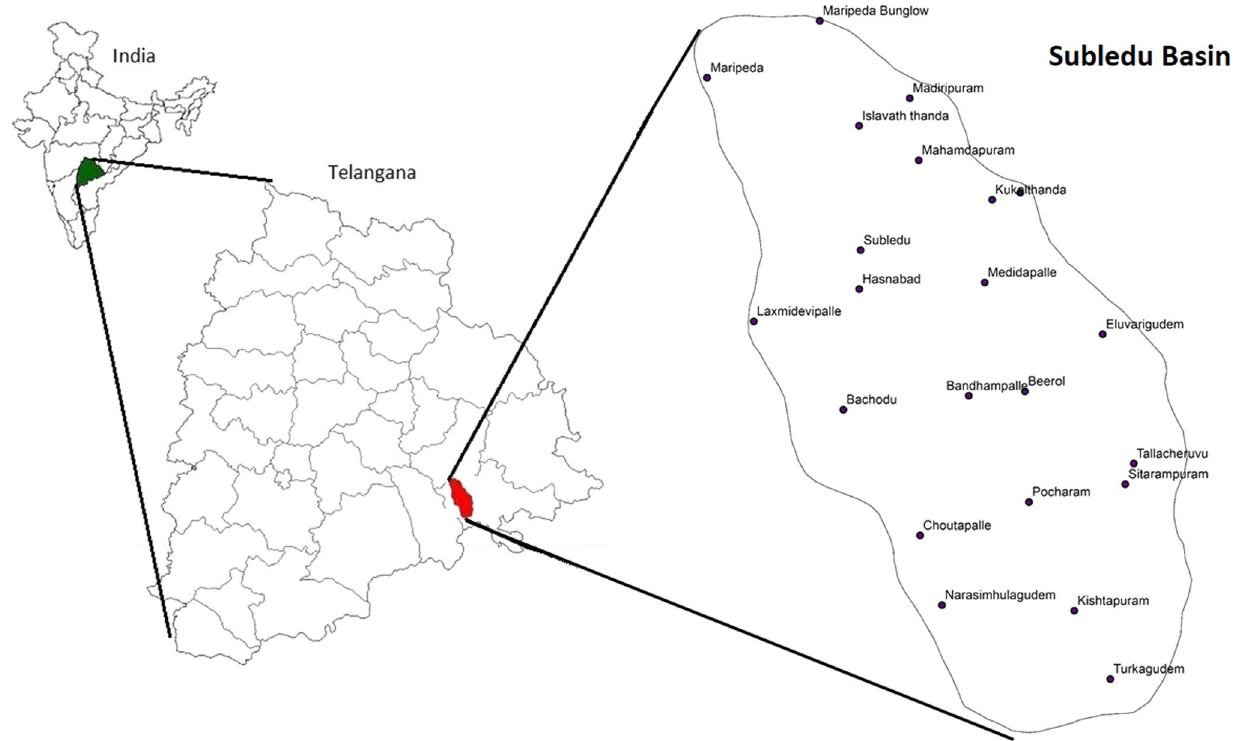
Fig. 1 Location of the study area map of Subledu Basin and the groundwater